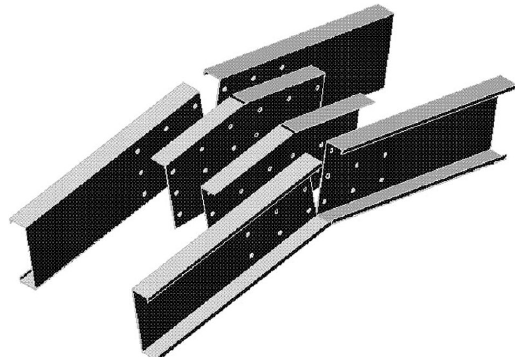
Fig. 1. Sleeve connection on the right; overlapped connection on the left